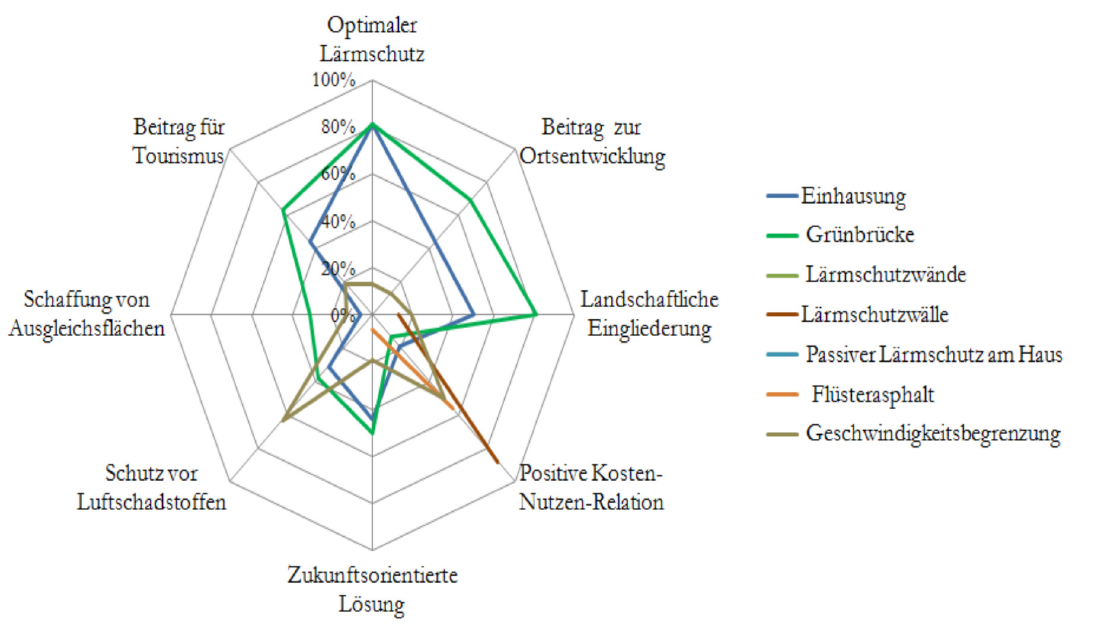
Figure 6: Criteria of several noise abatement measures according to experts (N = 15, multiple replies